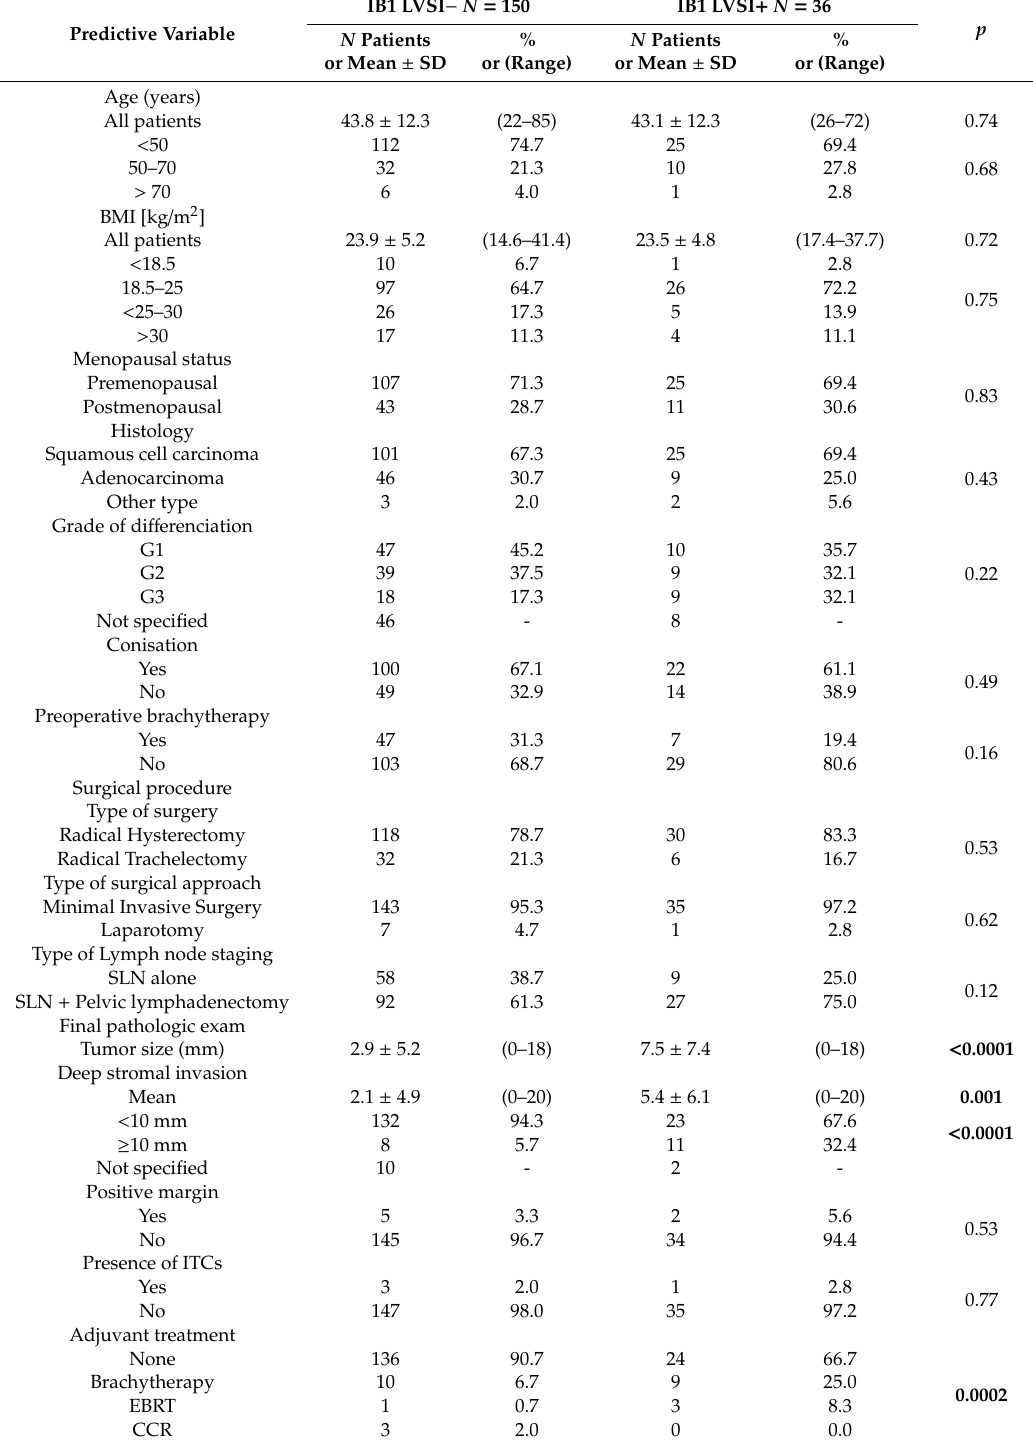
Table 2. Characteristics of IB1 2018 International Federation of Gynecology and Obstetrics (FIGO)